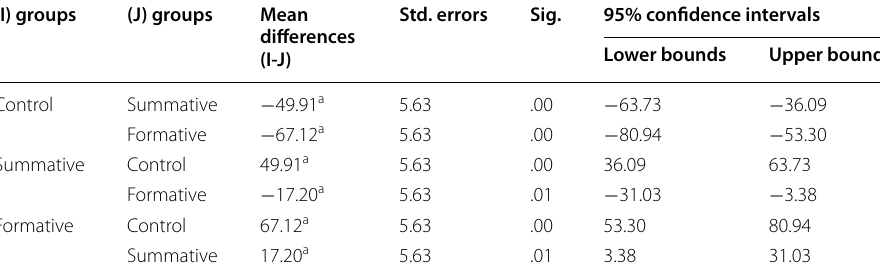
a The mean differences are significant at the 0.05 level